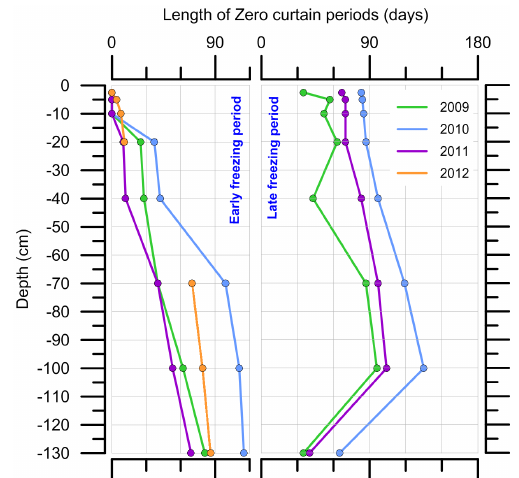
Figure 7. Length (in days) of the zero curtain periods at different depths during the early (left) and late (right) freezing